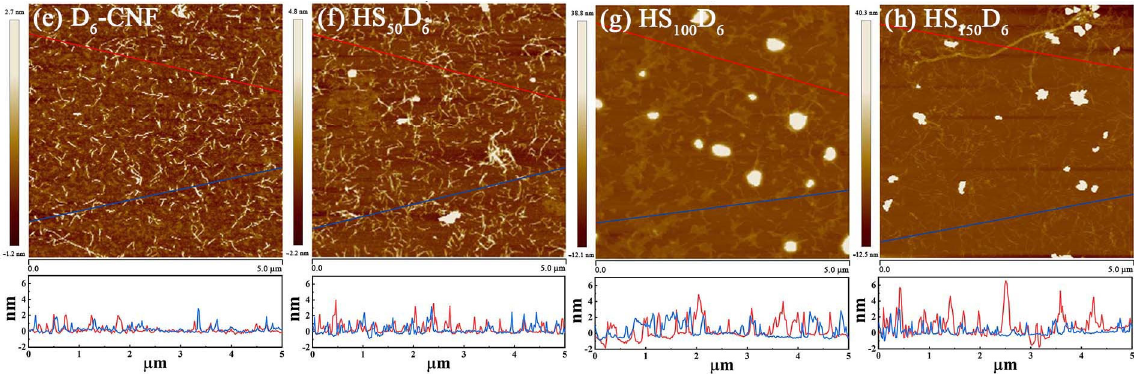
Figure 3. The AFM images of morphology of ( a ) D 6 -CNF and HN-SiO 2 in ( b ) HS 50 D 6 , ( c ) HS 100 D 6 , and ( d ) HS 150 D 6 . The AFM images of CNF in ( e ) D 6 -CNF, ( f ) HS 50 D 6 , ( g ) HS 100 D 6 , and ( h ) HS 150 D 6 .